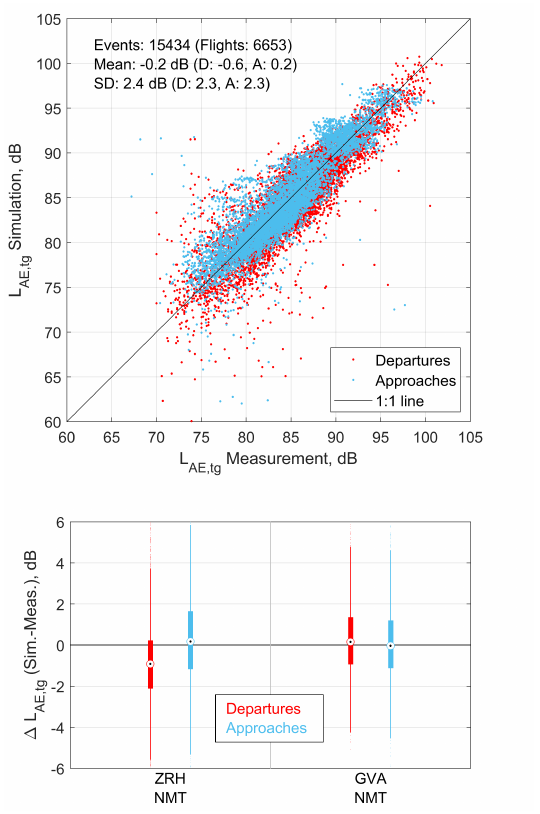
Figure 4: Comparison simulation vs. measurements for reduced models. Top: Scatterplot with all measurements, grouped by proce- dure (D: Departure; A: Approach; SD: Standard deviation). Bottom: Box-whisker-plots of the measurements, grouped by measurement origin and